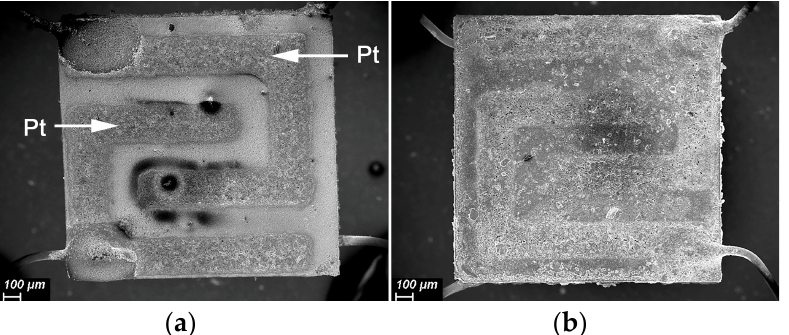
Figure 2. SEM image of alumina substrate with Pt contacts: ( a ) bare substrate, ( b ) covered with 2D SnO 2 .